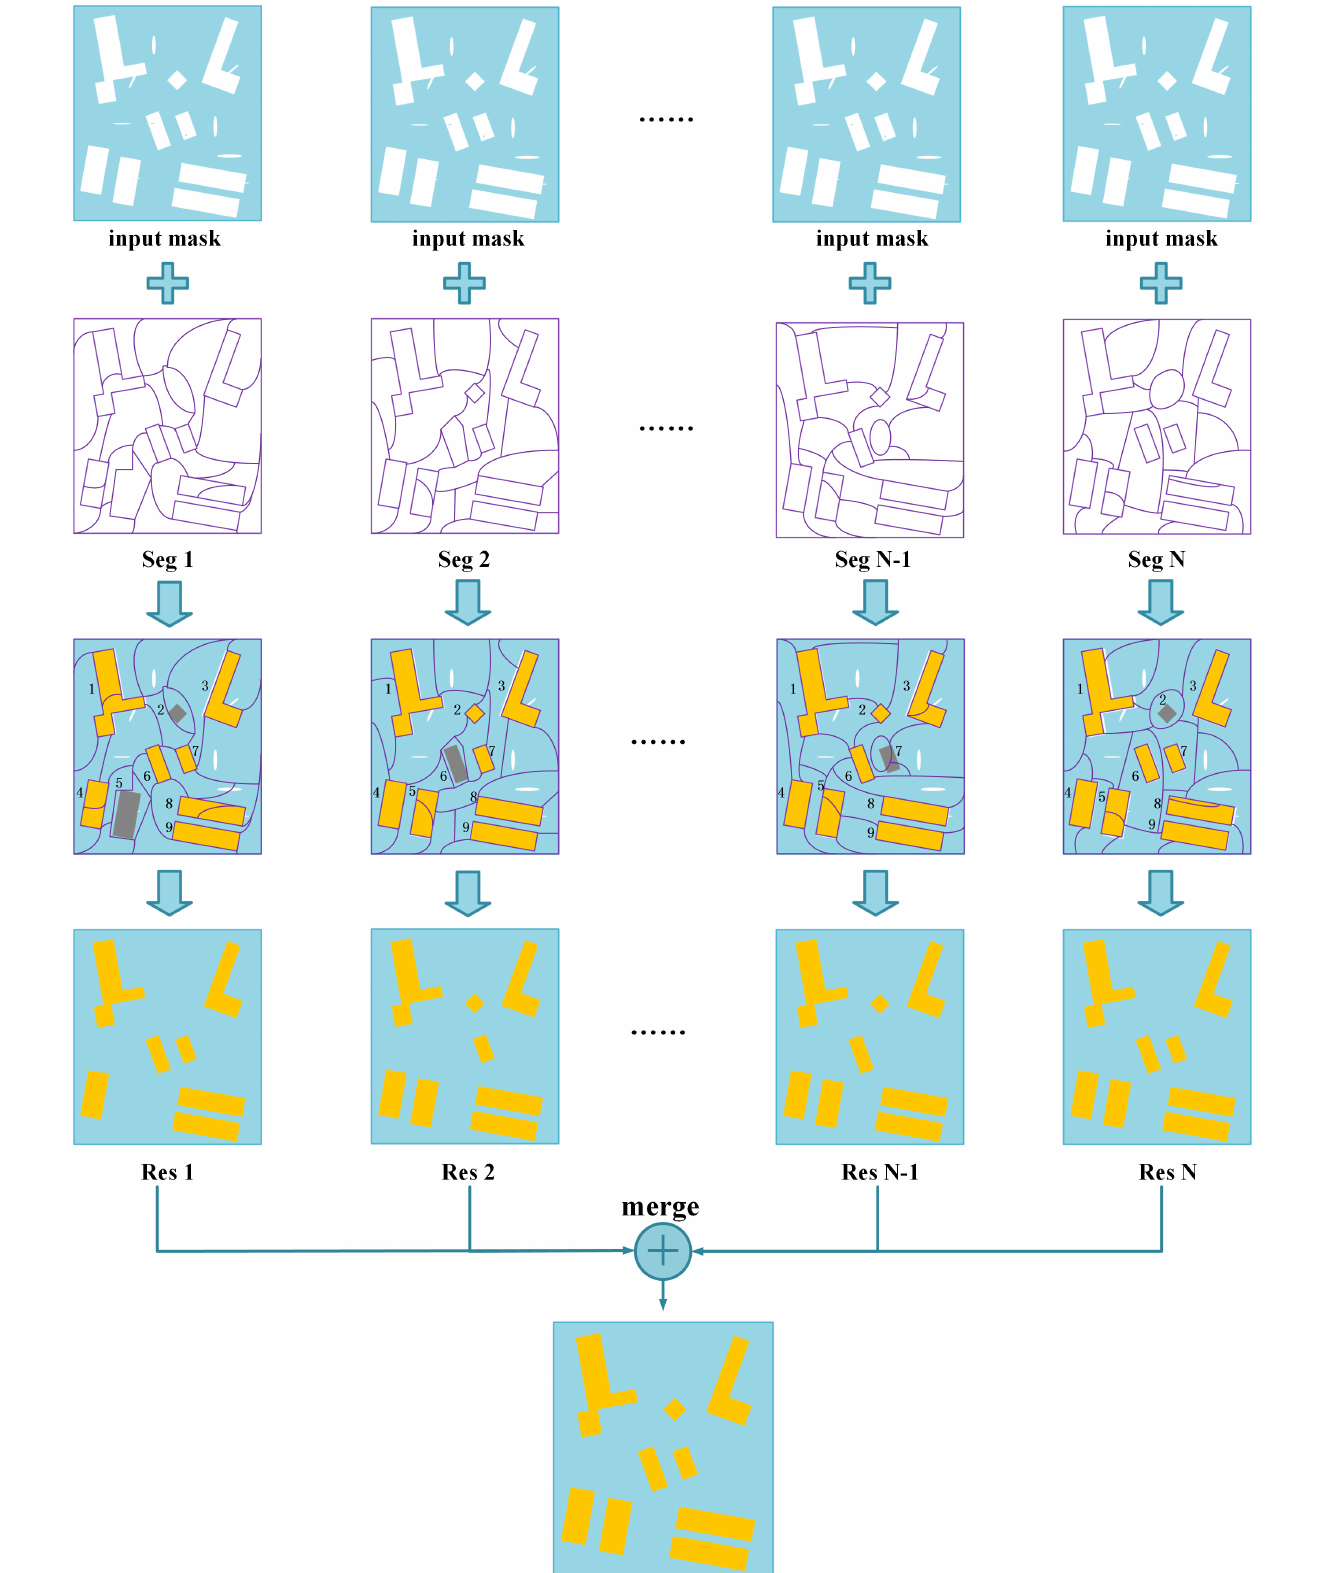
Figure 4. Detailed workflow for the region matching of our